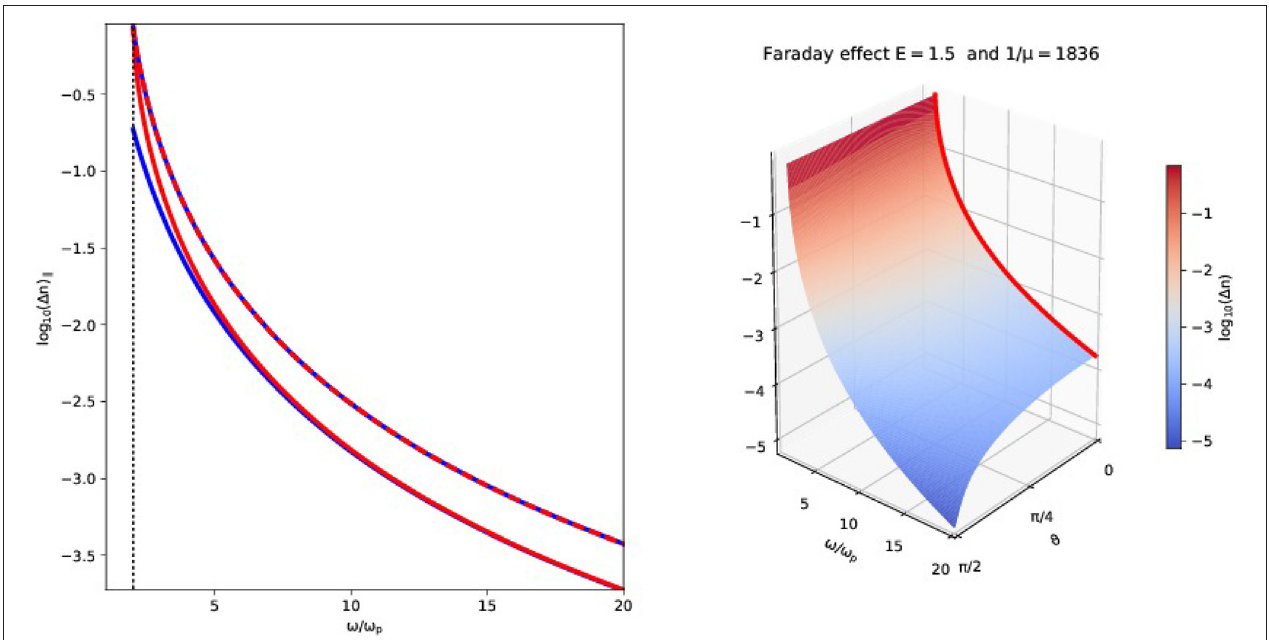
n R E /ω 3 as − ≈ n R is given by the red solid line. The −